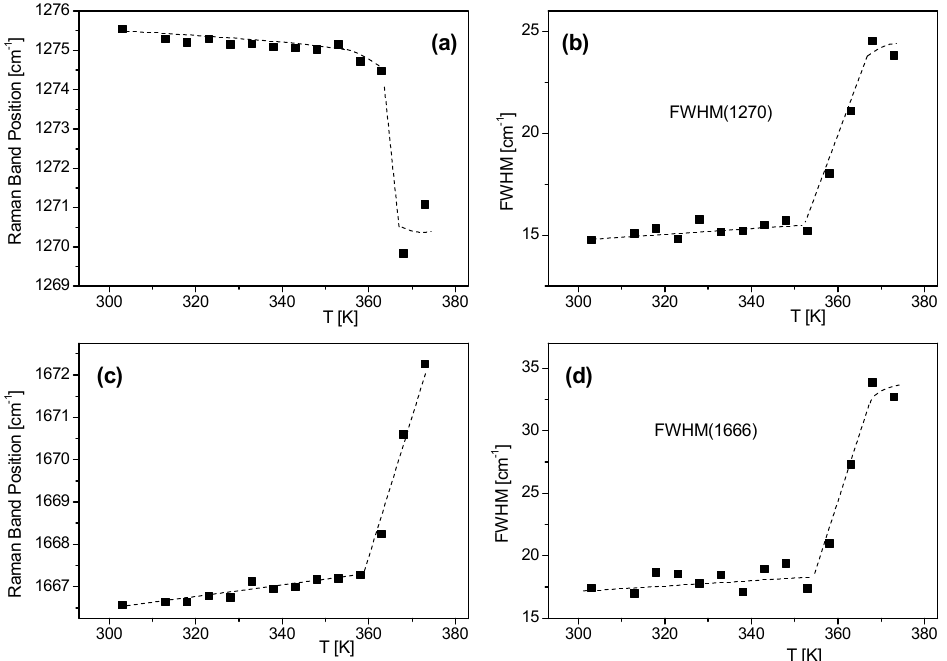
Figure 5. Temperature dependence of the Raman band position of FS related to amide III vibration ( a ) and its spectral width ( b ), amide I vibration ( c ) and its spectral width ( d ). The lines are guides for the eye.